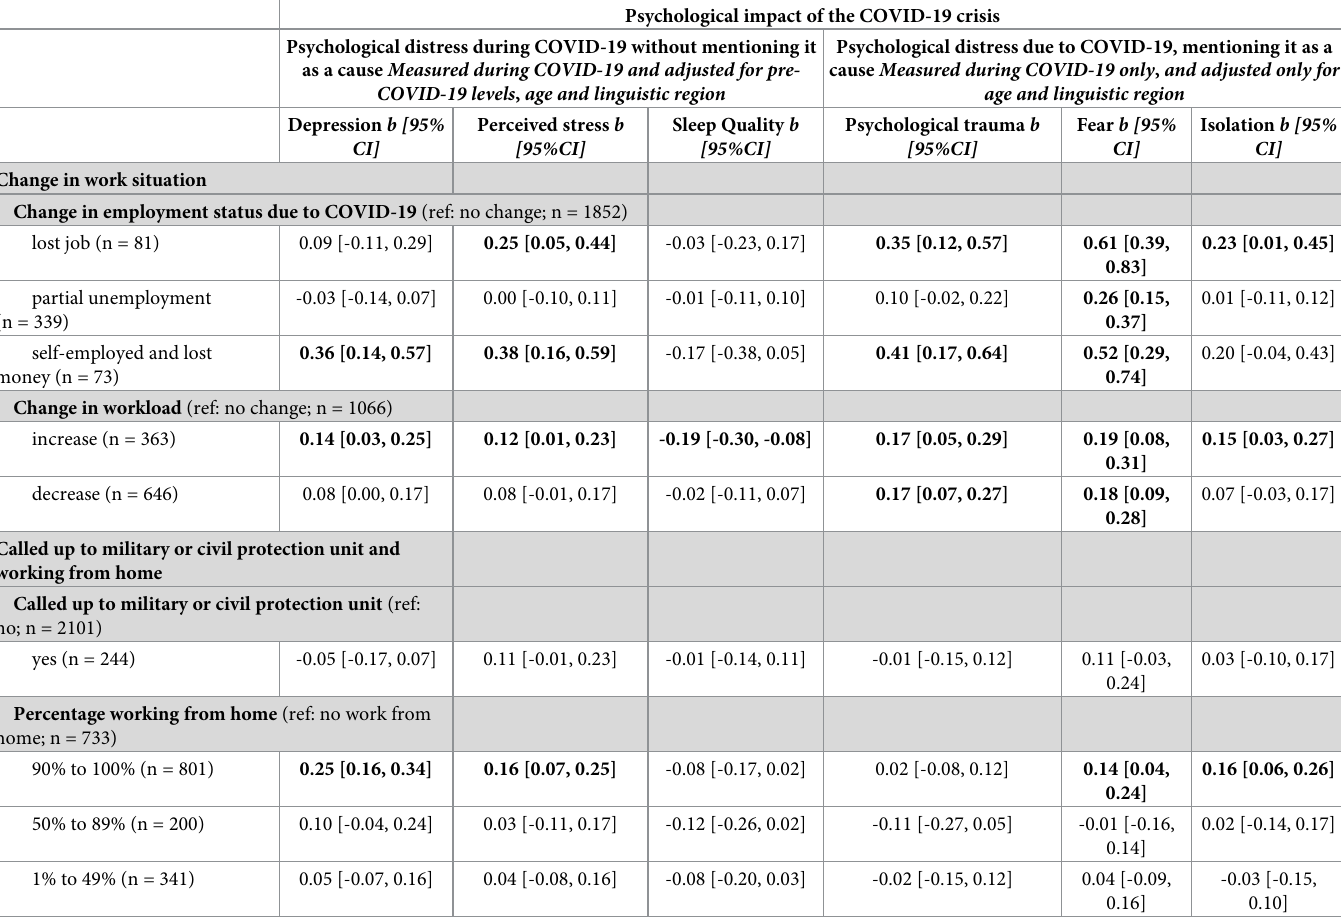
Table 4. Associations between psychological impact of the COVID-19 crisis with change in work situation, call up to military or civil protection unit and working from